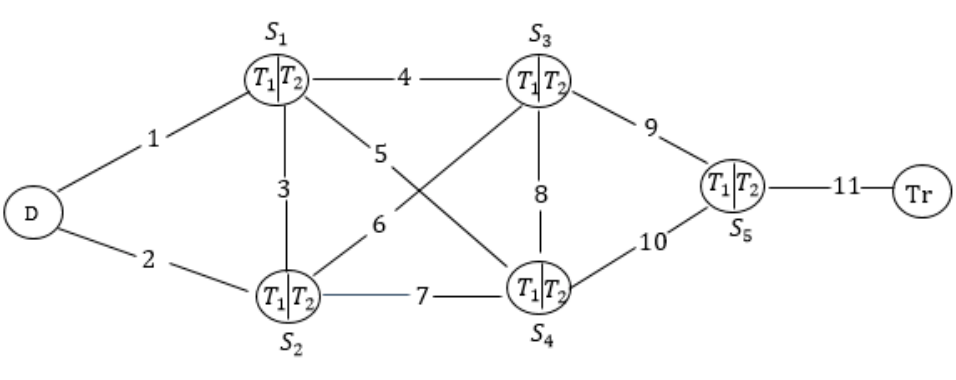
Figure 7. The network of the example.